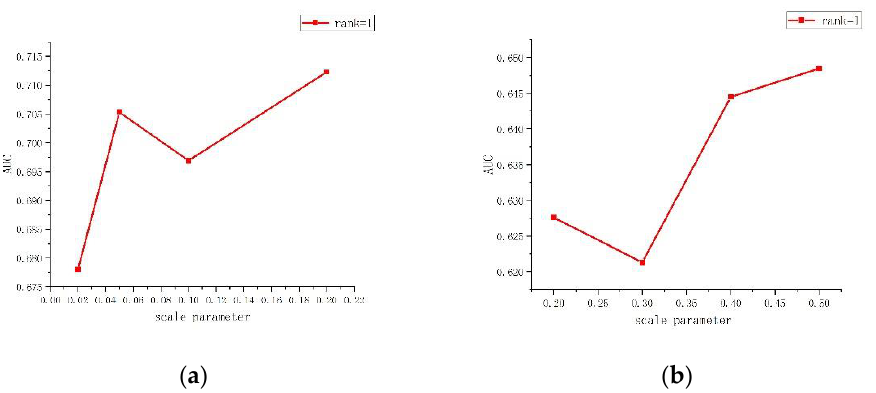
Figure 17. Analysis of the scale parameter ρ . ( a ) The metal plates data set and ( b ) the car data set.